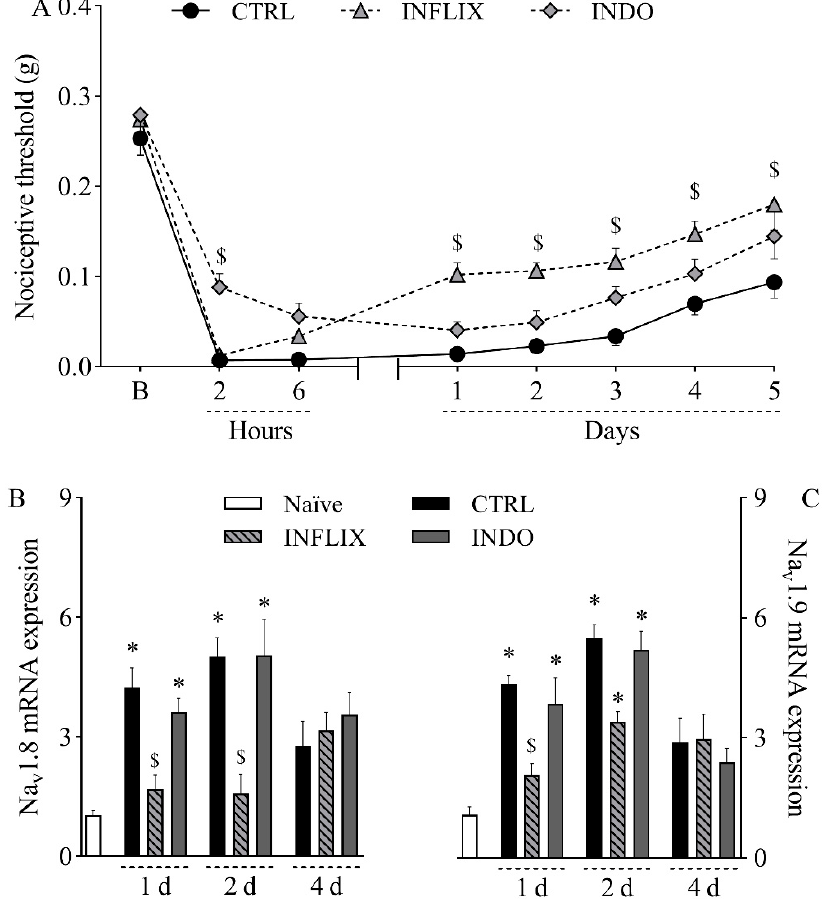
Figure 4. Contribution of TNF- α and prostanoids to mechanical hypernociception and upregulation of Na v 1.8 and Na v 1.9 in the dorsal root ganglia following plantar incision. Mice were treated with the anti-TNF- α monoclonal antibody infliximab (INFLIX; 10 mg/kg, intraperitoneally), the non- selective COX inhibitor indomethacin (INDO; 10 mg/kg, orally), or the vehicle (CTRL; control group). Plantar incision model of postoperative pain was induced one hour later. No surgical procedures nor treatments were performed on naïve mice. ( A ) The mechanical nociceptive threshold (axis of ordinates) was evaluated at baseline ( B ) and at different times in hours and days after plantar inci- sion (axis of abscissas). Values represent the filament weight (g) to which mice respond in 50% of presentations. Data are expressed as means ± SD ( n = 6). $ p < 0.05 compared with CTRL group. Two- way ANOVA followed by Bonferroni’s test. ( B , C ) The levels of Na v 1.8 mRNA ( B ) and Na v 1.9 mRNA ( C ) in the DRG (axis of ordinates) were determined by Real-Time PCR at different times in days (d) after plantar incision (axis of abscissas). Target gene expression (2 −ΔΔ Ct ) was determined using Gapdh as housekeeping gene. Data are expressed as means ± SD ( n = 6). * p < 0.05 compared with naïve group. $ p < 0.05 compared with CTRL group. One-way ANOVA followed by Tukey’s test. 2.5. The p38 MAPK/NF- κ B Pathway Plays a Role in the Pathophysiology of the Mouse Model of Incisional Pain To further investigate the pathophysiology of the mouse model of incisional pain, the involvement of MAPK enzymes and the transcription factor NF- κ B was evaluated by pharmacological assays. The intraperitoneal treatment with the NF-kB antagonist PDTC at 100 mg/kg significantly reduced mechanical hypernociception from two hours to four days after incision, as determined by comparison with the control group (Figure 5A; p < 0.05). It is noteworthy that the lack of statistical difference at five hours can be attributed to the return of mechanical thresholds in the control group to baseline values, since